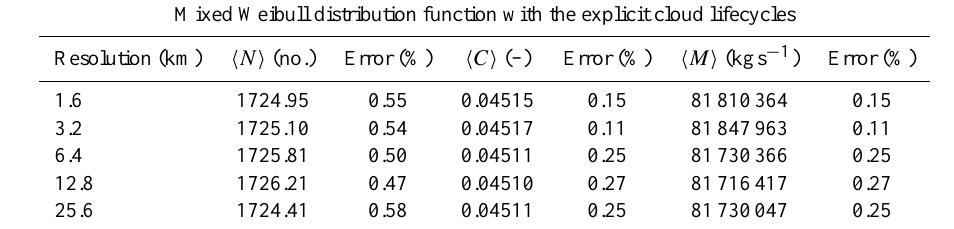
Table 4. Ensemble average cloud properties resulting from the stochastic model ensemble runs with the different horizontal resolutions. Mixed Weibull distribution function with the explicit cloud lifecycles Resolution (km)